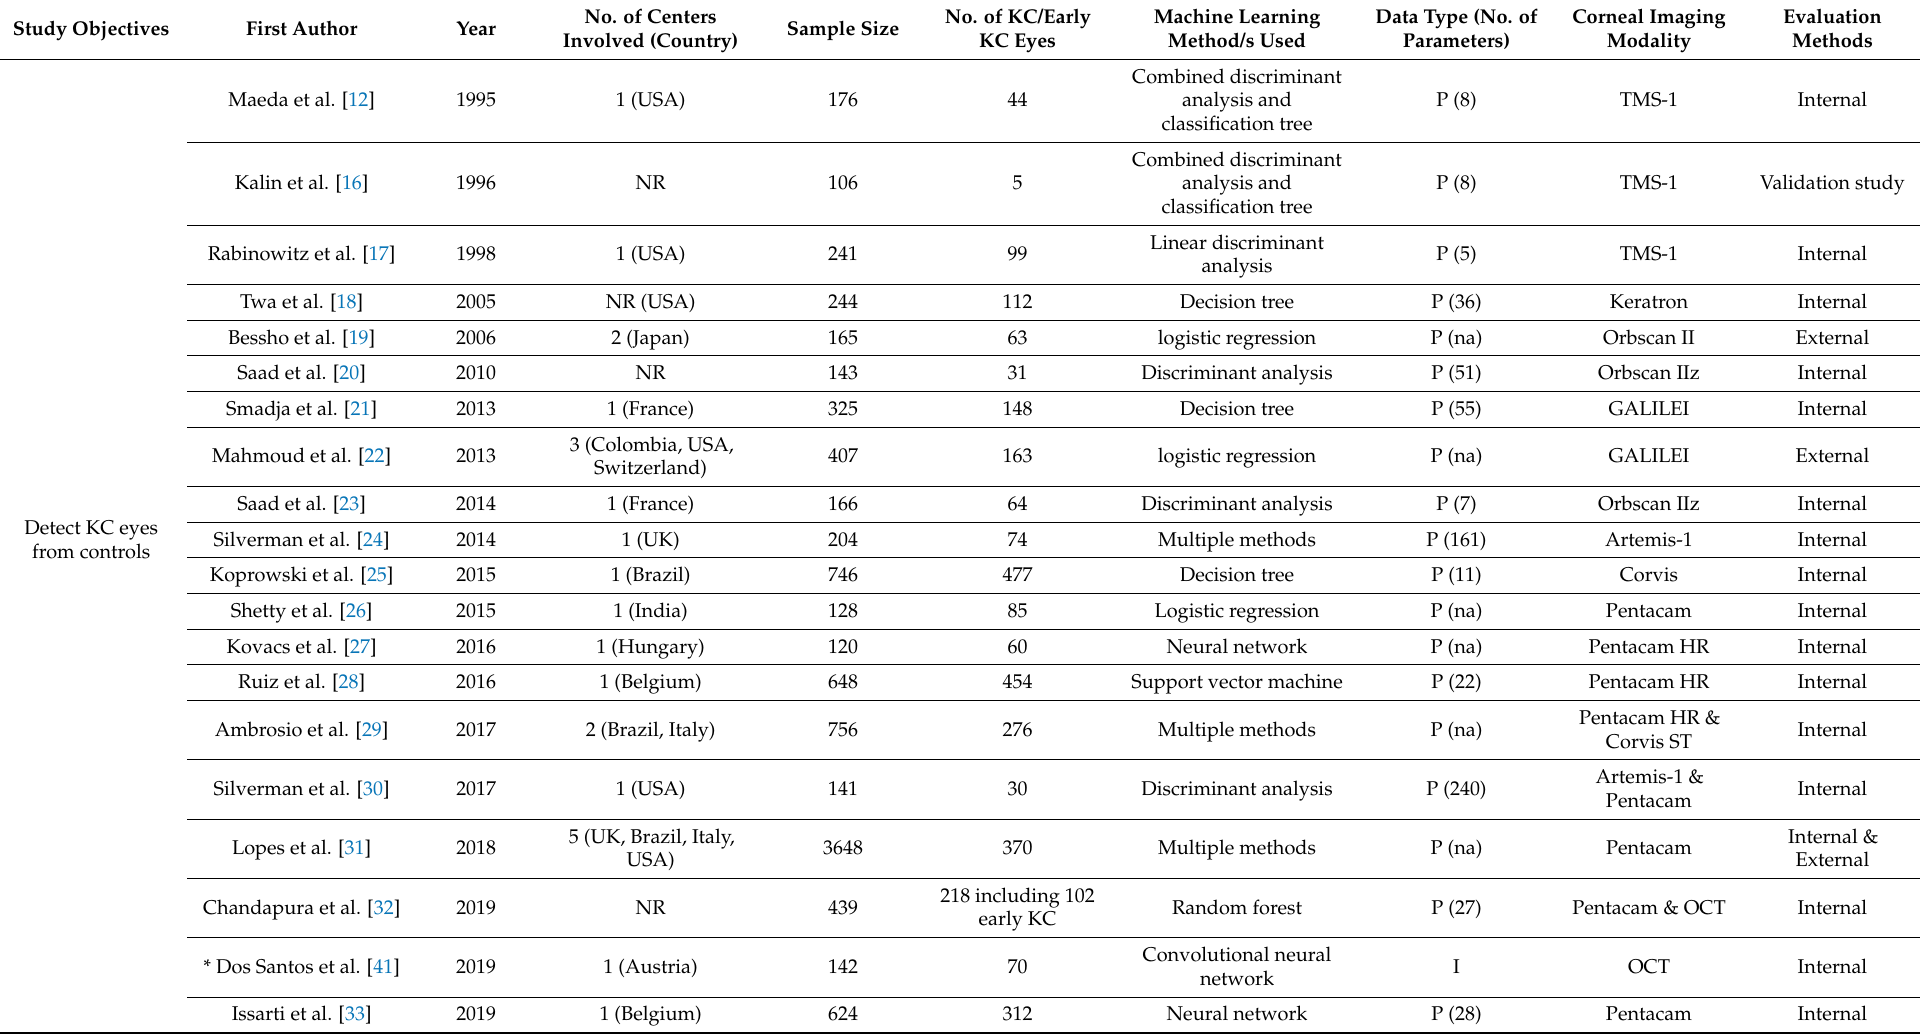
Table 1. Identified studies using machine learning in detection of KC and early